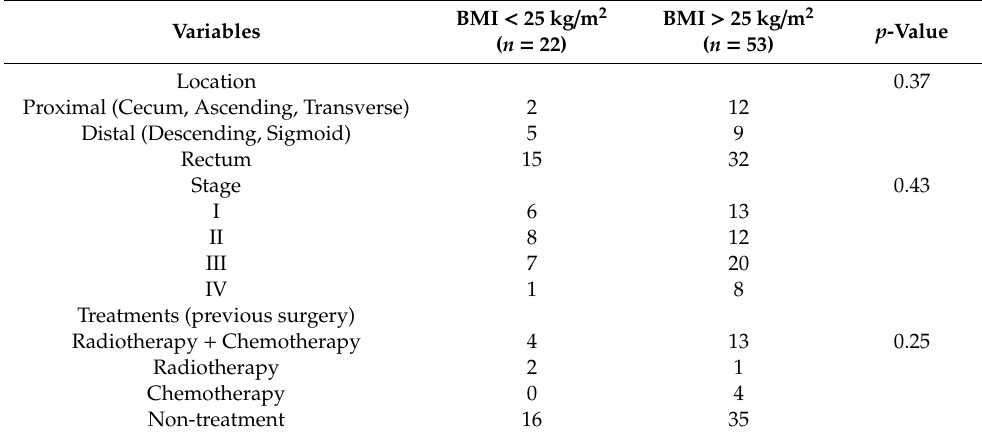
Abbreviations: BMI—Body mass index; CRC—colorectal